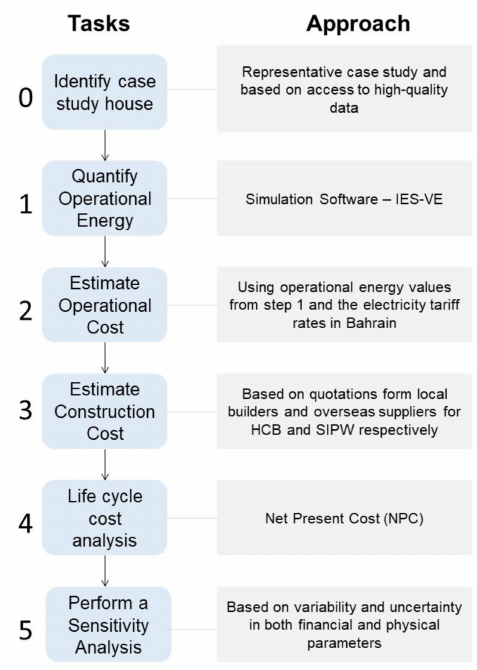
Figure 2. Overall research